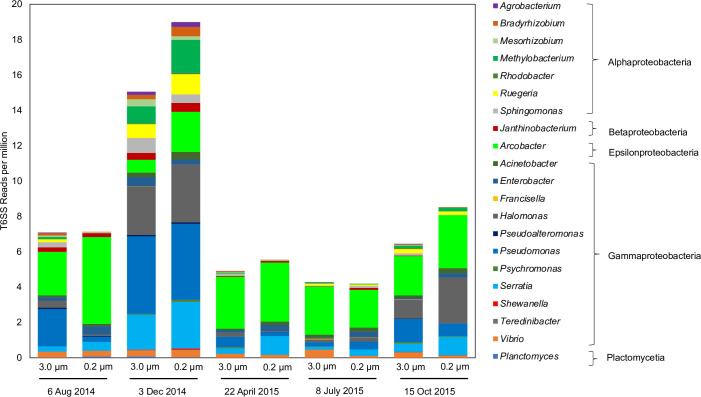
Metagenome sequence reads (in RPM) of T6SS core genes from 3.0 and 0.2 μm water size fractions by sample date.Samples span seasons and broad ranges of environmental conditions such as high and low chlorophyll level, toxic phytoplankton bloom, and nutrient levels. Twenty-one bacterial genera from several classes known to harbor five core T6SS genes were confirmed and are present at varying rpm across samples.